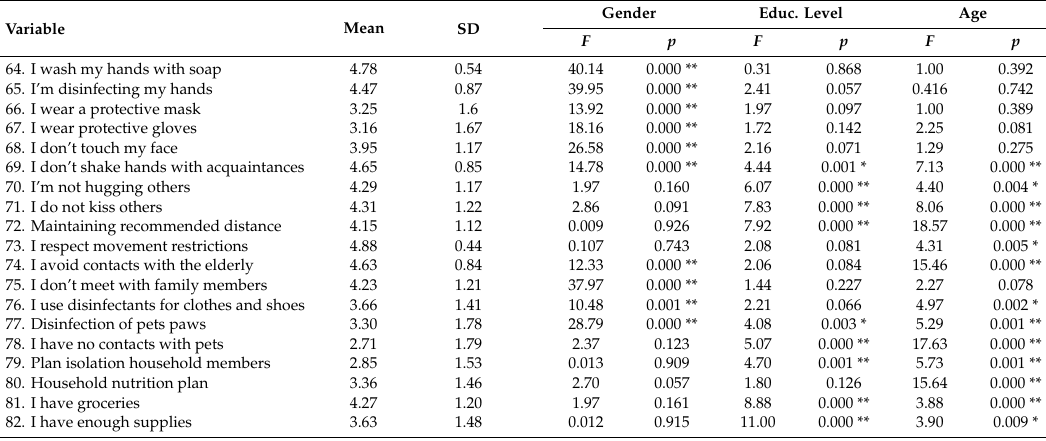
Table 7. One-way ANOVA results of di ff erent groups of independent variables and variables on the preventive measures for coronavirus